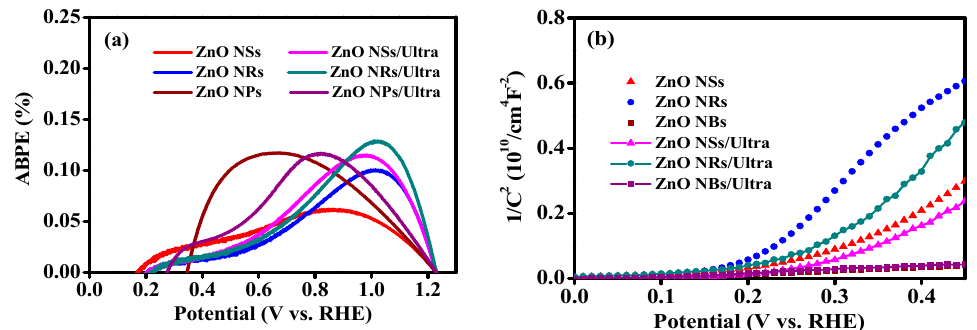
Figure 9. ( a ) Applied bias photon–current efficiency curves. ( b ) Mott–Schottky (M-S) plots that were measured under 1000 Hz of the photoanodes.